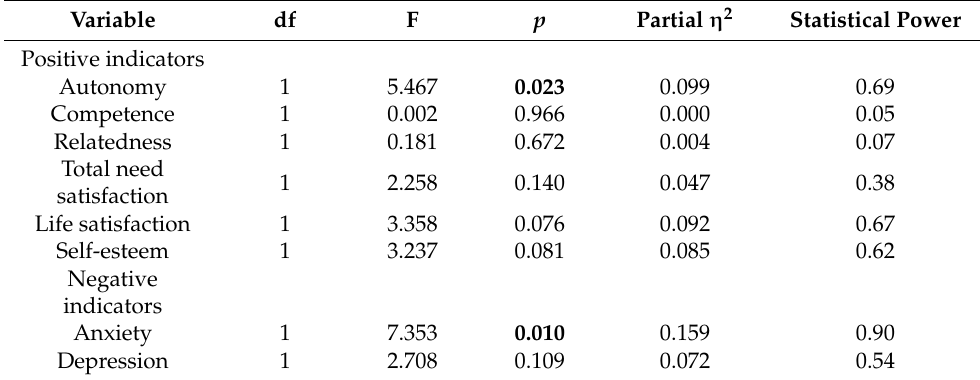
Table 3. Results of ANCOVA for positive and negative indicators of mental